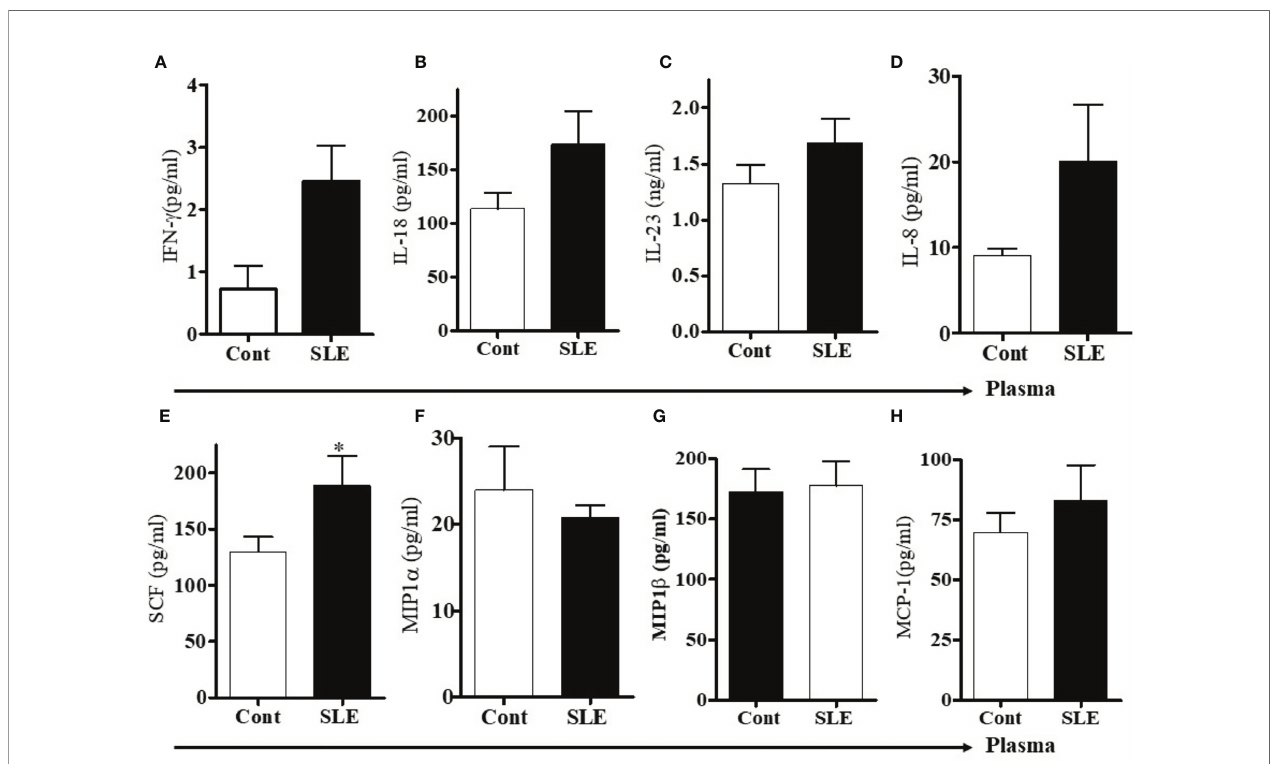
FIGURE 4 | Plasma levels of pro-in fl ammatory cytokines, chemokines including stem cell factor (SCF) were increased in SLE patients. To address the differences of pro-in fl ammatory cytokines and chemokines between healthy controls and SLE patients, plasma levels of pro-in fl ammatory cytokines, chemokines and stem cell factor (SCF) were measured in healthy controls (n=10-12) and SLE patients (n= 10-12) by RBM multiplex assay. (A) IFN- g , (B) IL-18, (C) IL-23, (D) IL-8, (E) Stem cell factor (SCF), (F) MIP1 a , (G) MIP1 b , and (H) MCP-1. *p <